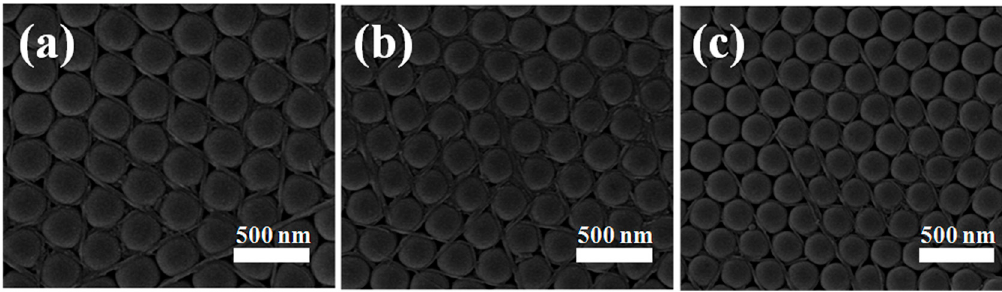
Figure 6. SEM images showing the cross-linking effect between MWCNTs and PS particles: ( a ) red film; ( b ) green film; ( c ) blue film.